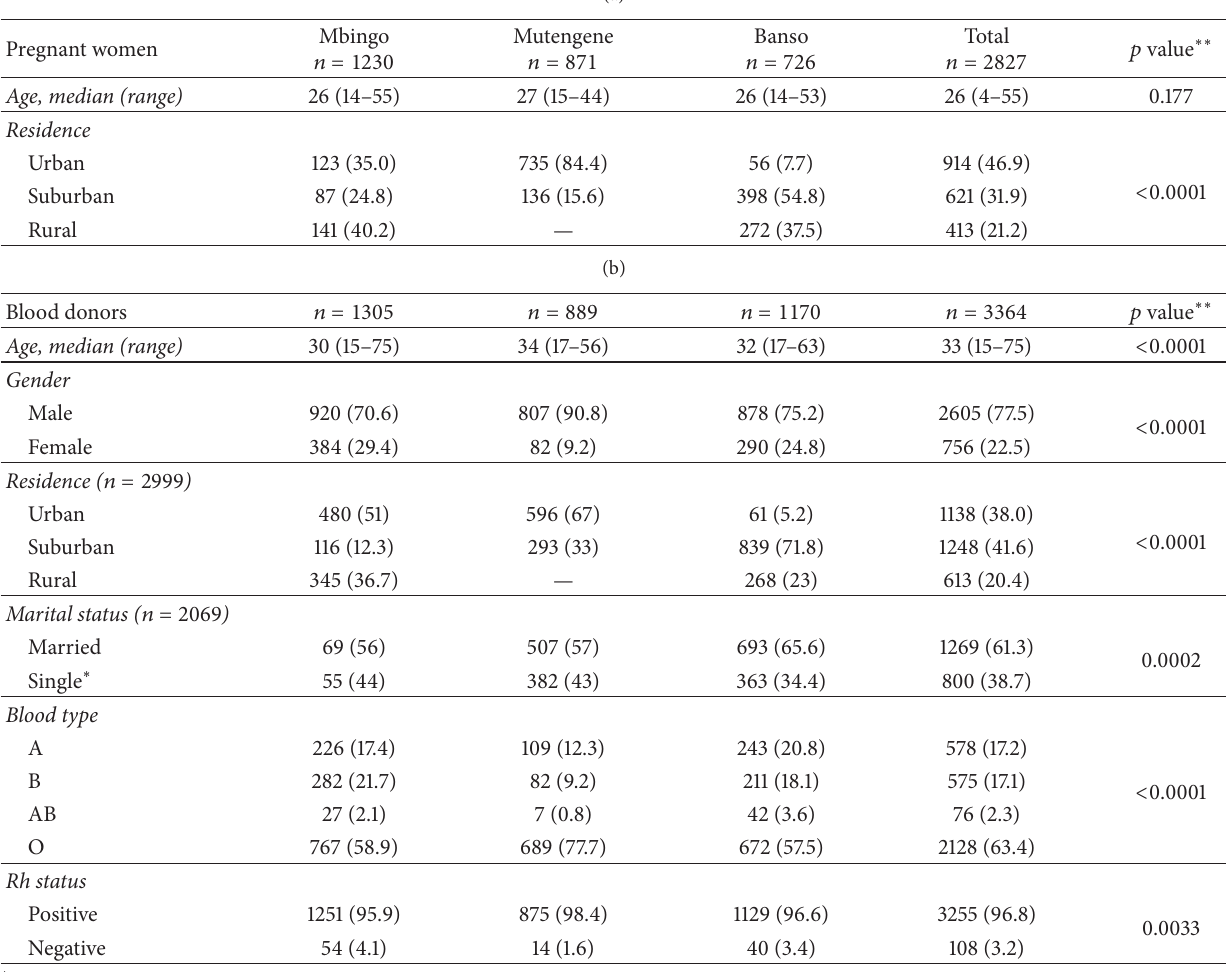
Table 1: Demographics of pregnant women and voluntary blood donors ∗ , 𝑛